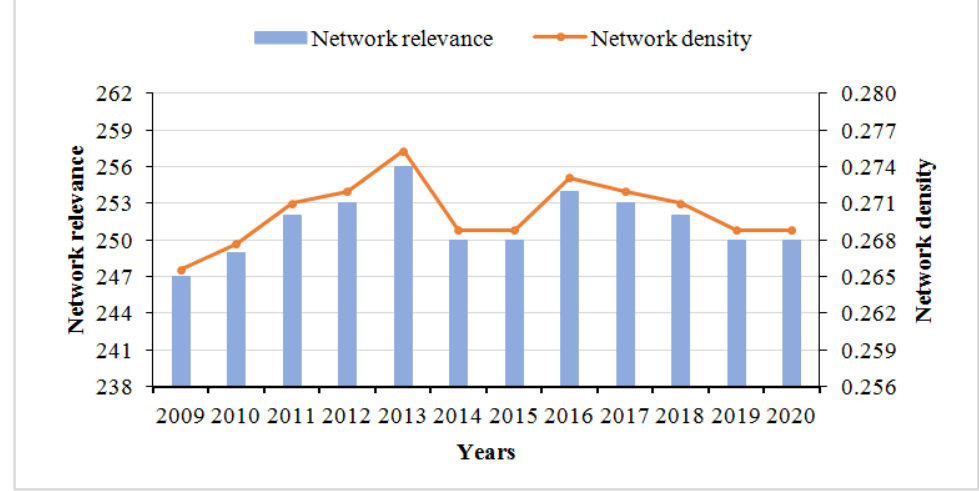
Figure 2. Trend of network relevance and network density from 2009 to 2020.